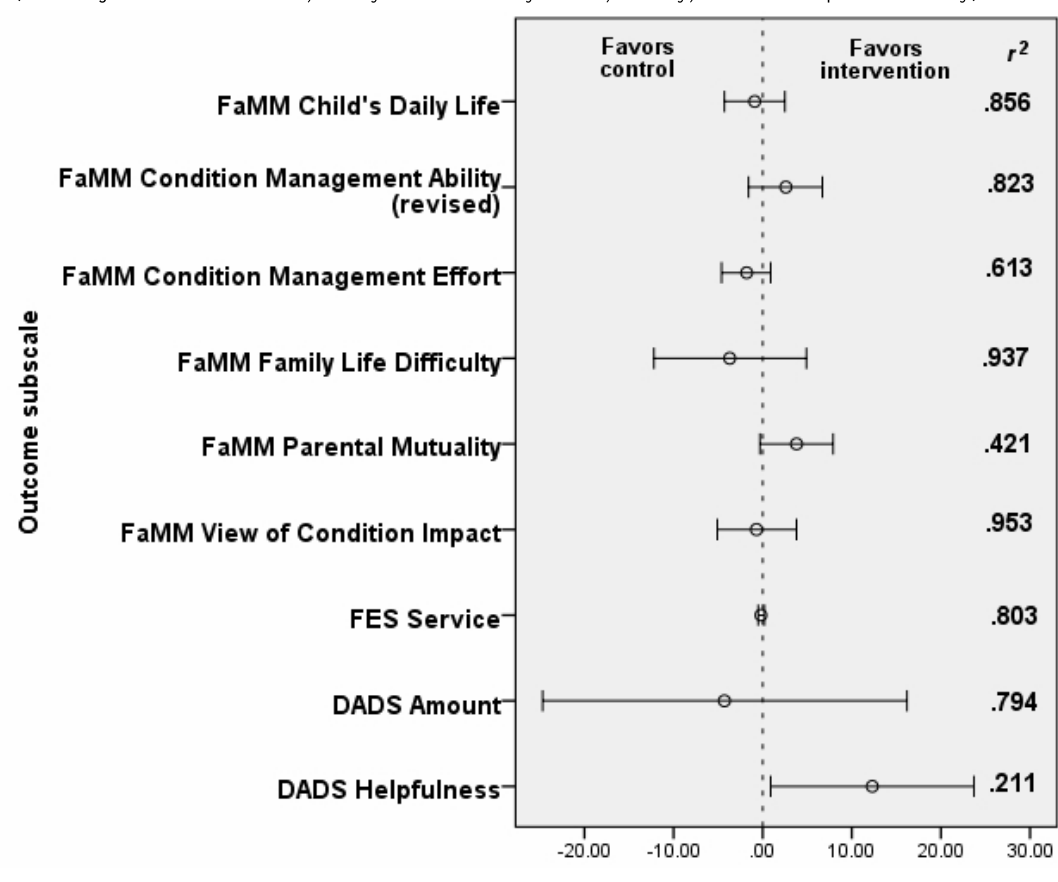
Figure 4. Differences in marginal means between the study groups in terms of whether the difference favored the intervention (OPIS) group or